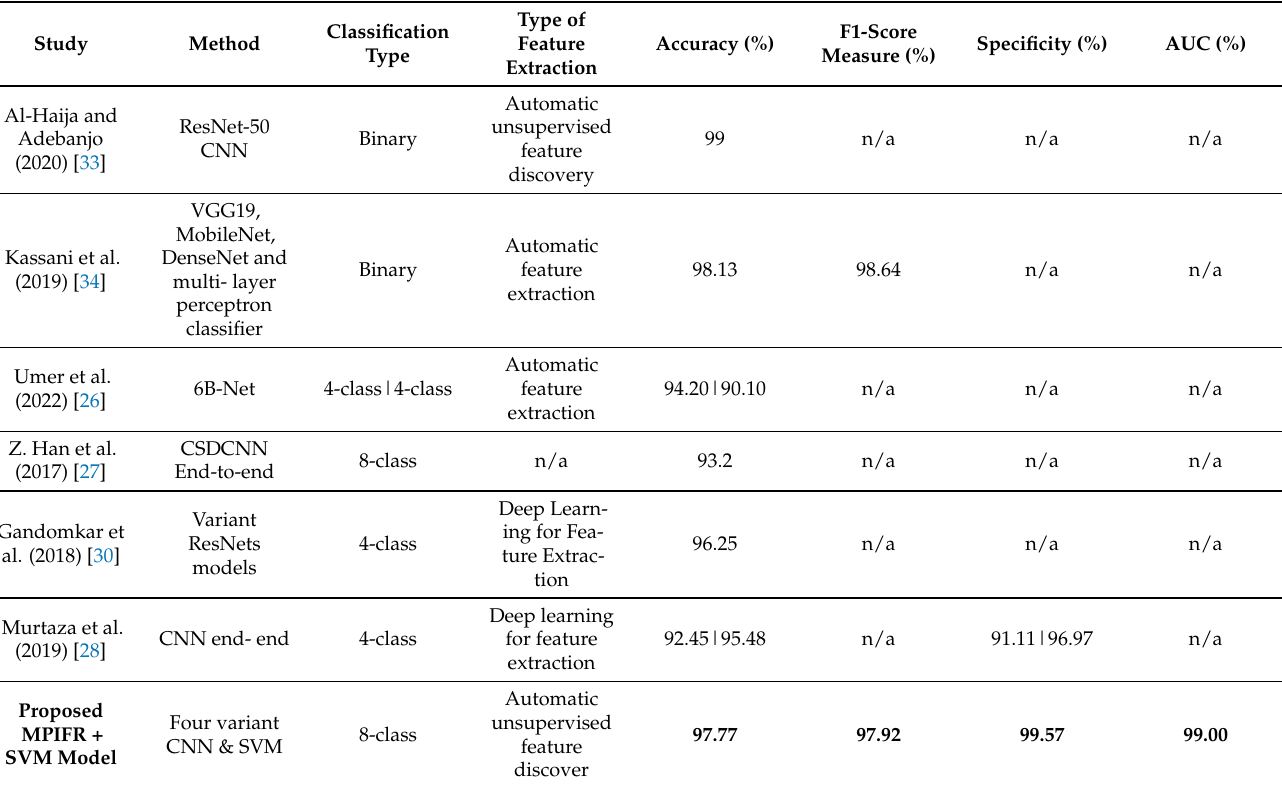
Table 1. Prior models for 2- and 4-class BC classification including performance comparisons. Our proposed approach (in bold) outperforms prior